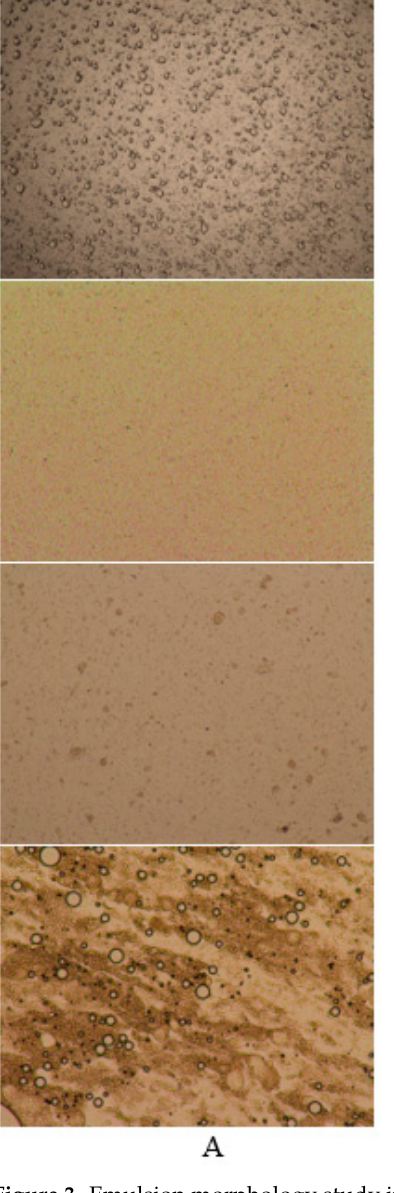
Figure 3. Emulsion morphology study in NEO-loaded emulsions using di ff erent materials. ( A ) The emulsions before homogenization and ( B ) after homogenization (magnification 10 × ) ** The code is given in Table 1.